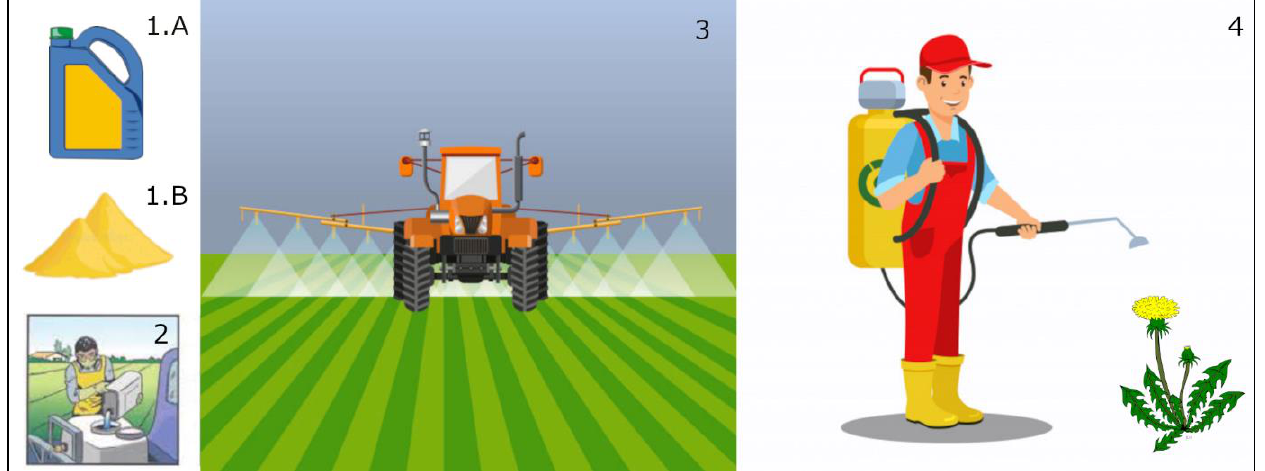
Figure 1. Illustration of risk for human health related to the use of EOs as bioherbicides. ( 1.A ) Liquid product, ( 1.B ) solid product, ( 2 ) filling, ( 3 ) application by tractor/cabin, ( 4 ) application by backpack sprayer with personal protective equip- ment.